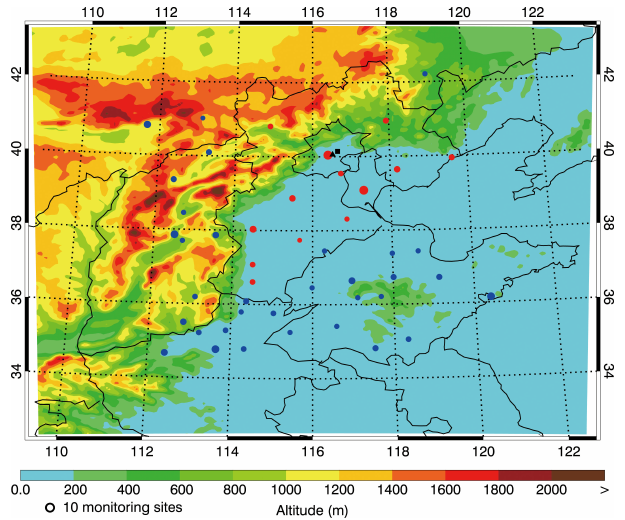
Figure 1. WRF-CHEM simulation domain. The filled red (in BTH) and blue (outside of BTH) circles represent centers of cities with ambient monitoring sites. The size of the circle denotes the number of ambient monitoring sites of cities. The filled black triangle and rectangle denote the deployment location of the HR-ToF-AMS and the surface meteorological site in Beijing,